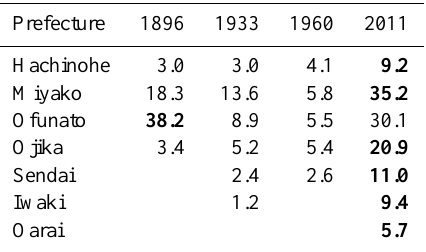
Table 1. Wave heights in meters recorded along the eastern coast of Japan for recorded tsunamis. Source: Japanese Society of Civil En- gineers. Bold numbers indicate maximum wave heights recorded.